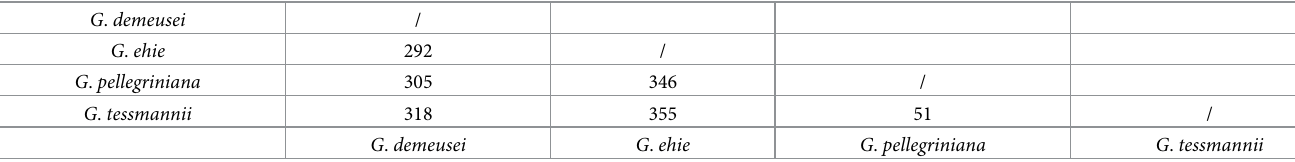
Table 6. SNP variation in the plastid CDS regions among Guibourtia species.